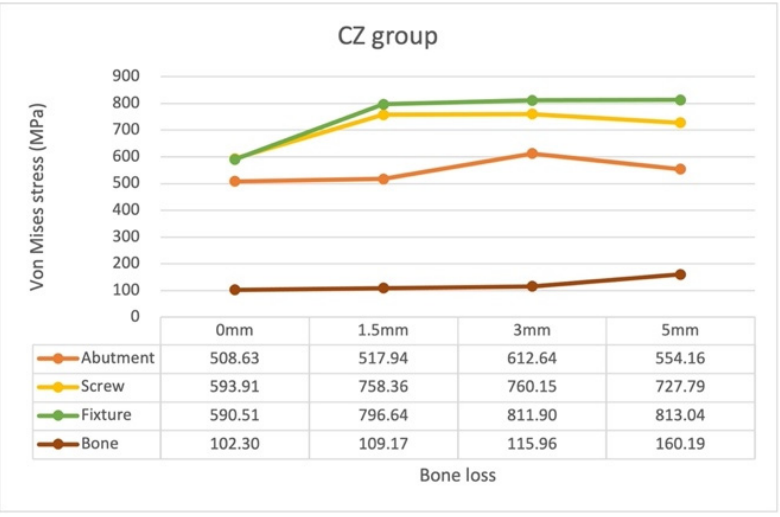
Figure 14. Maximum von Mises stress on the abutment, screw, fixture, and bone in the CZ groups with different bone loss levels.